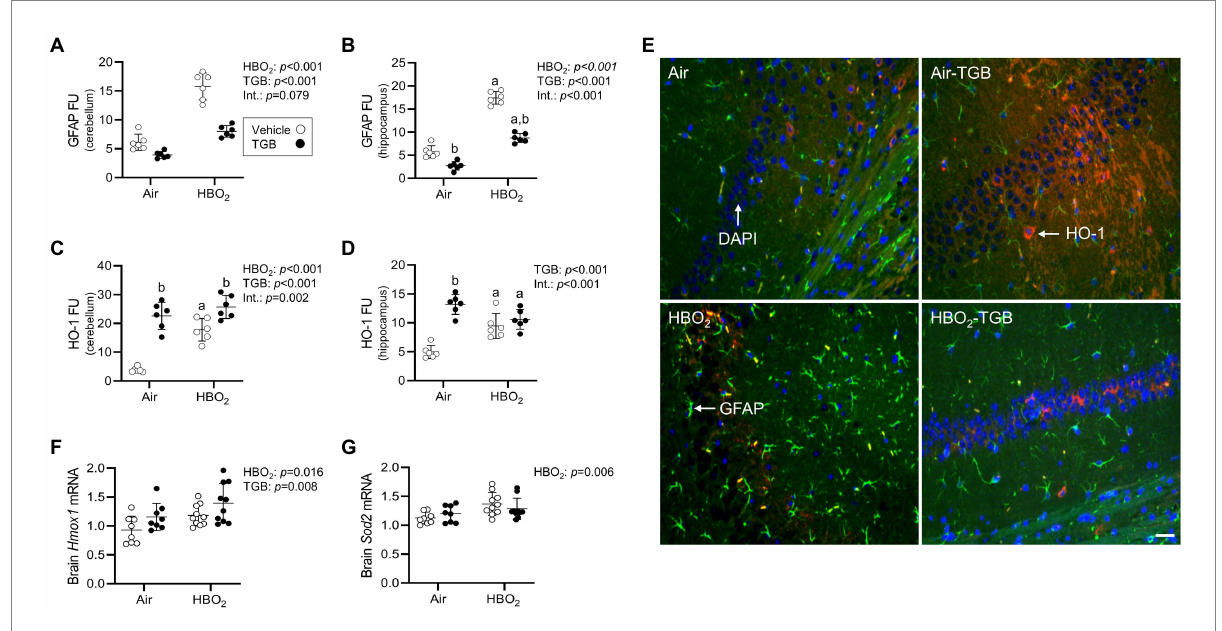
FIGURE 3 Reactive astrocytes and antioxidant responses in mice exposed to extreme HBO 2 . Mice were pretreated with 0.9% NaCl or TGB (4.8 mg/kg body weight) 30 min before exposure to air or 5 ATA oxygen for 30 min. (A–D) Quantification of glial fibrillary acid protein (GFAP) and heme oxygenase-1 (HO-1) in the cerebellum and hippocampus. (E) Representative images from the hippocampus. HO-1 (red), GFAP (green), and DAPI (blue). Scale bar = 20 μ m. (F,G) Hmox1 and mitochondrial superoxide dismutase ( Sod2 ) mRNA expression in brain homogenates ( n = 8–10/group). Main effect of a HBO 2 and b TGB, p <